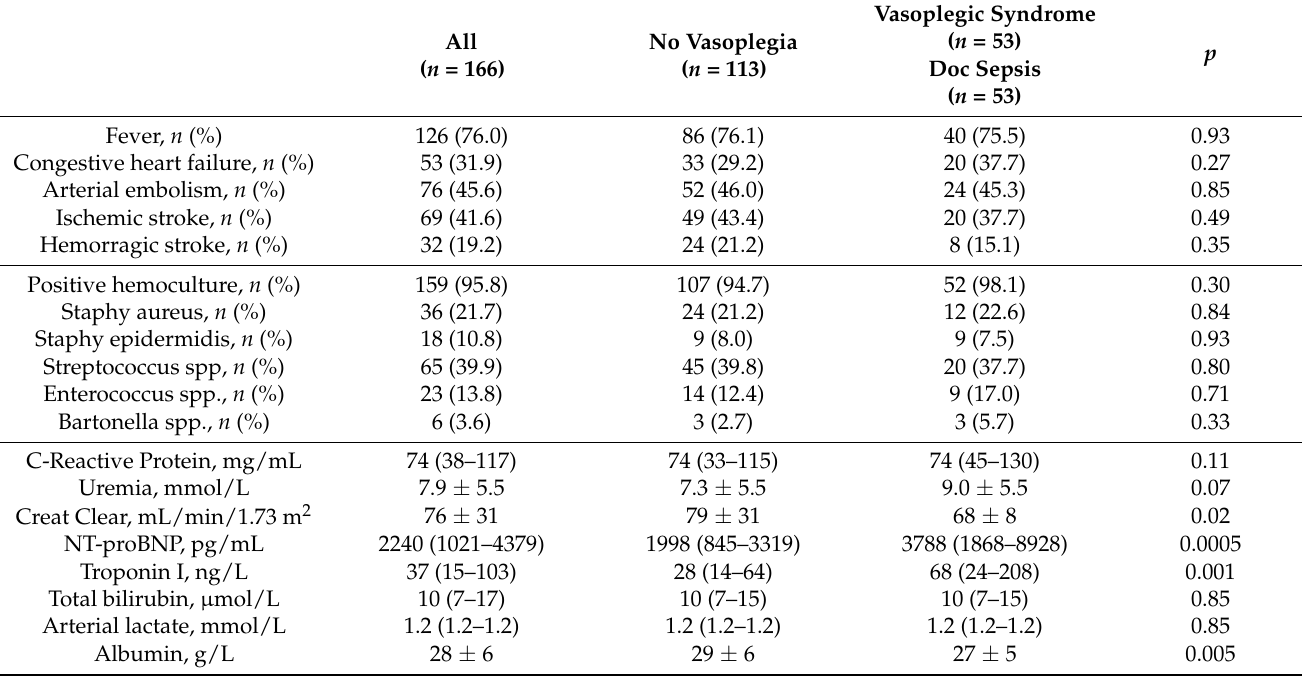
Table 2. Clinical characteristics of the